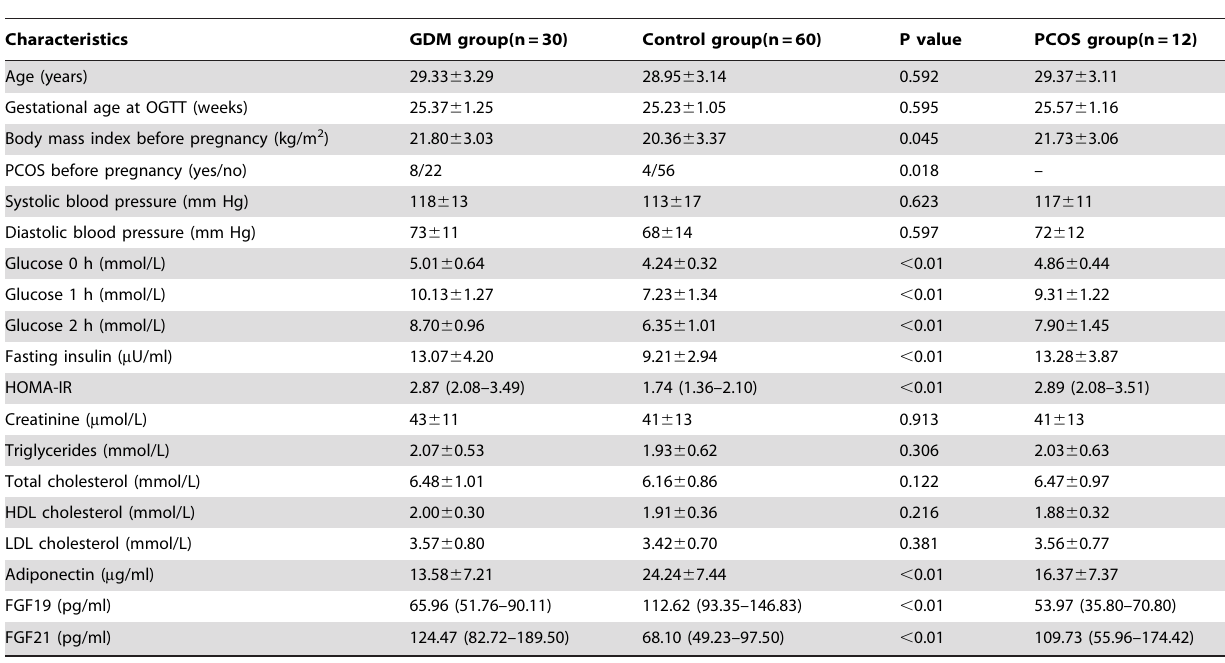
Table 1. General characteristics of the study